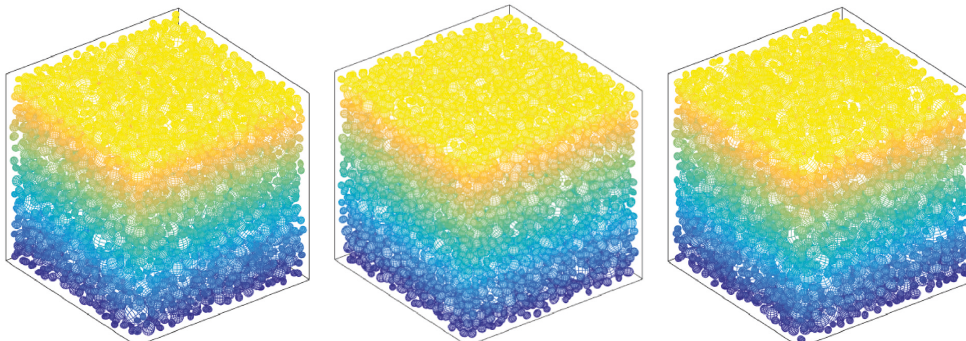
Figure 8: Single-graded ellipsoidal random aggregate, d ∈ (4.75, 31.5) mm, Q